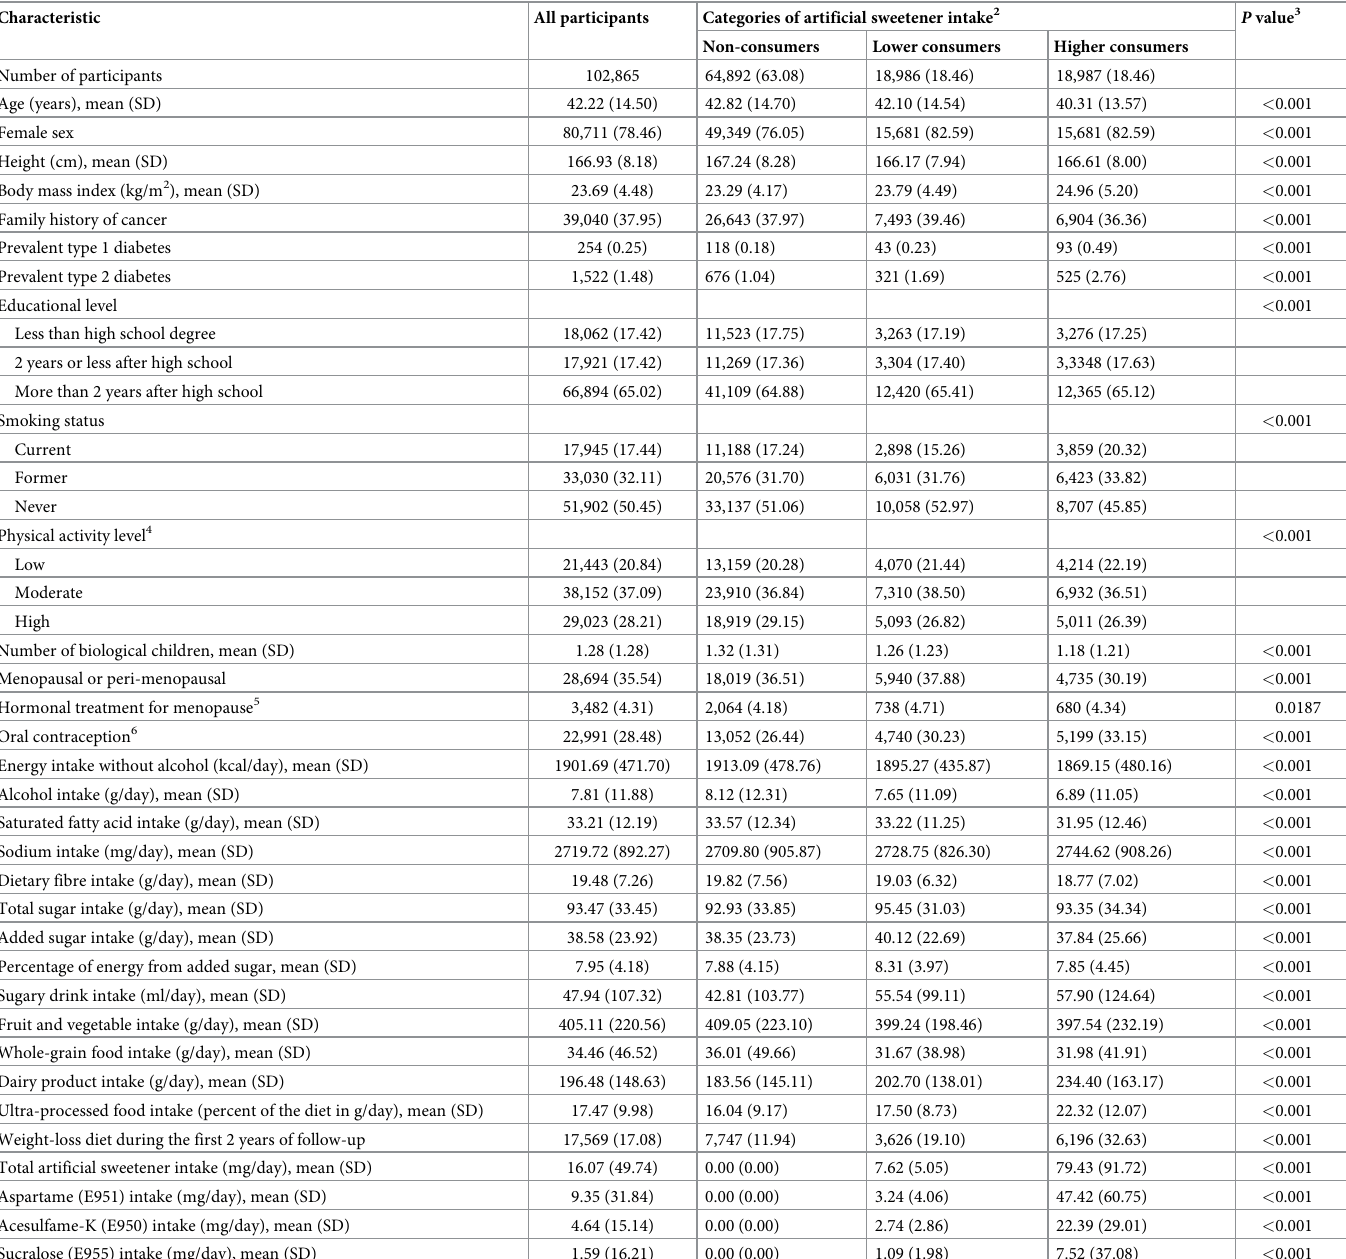
Table 1. Baseline characteristics of the study population, NutriNet-Sante´ cohort, France, 2009–2021 ( n = 102,865) 1